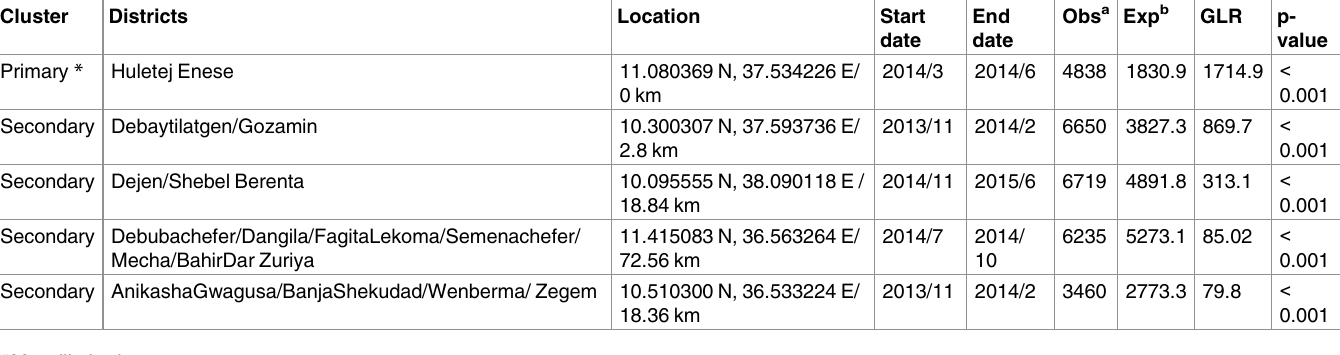
Table 1. Results from space-time permutation scan statistical analysis of childhood diarrhea in northwest Ethiopia, from July 2013 to June 2015.